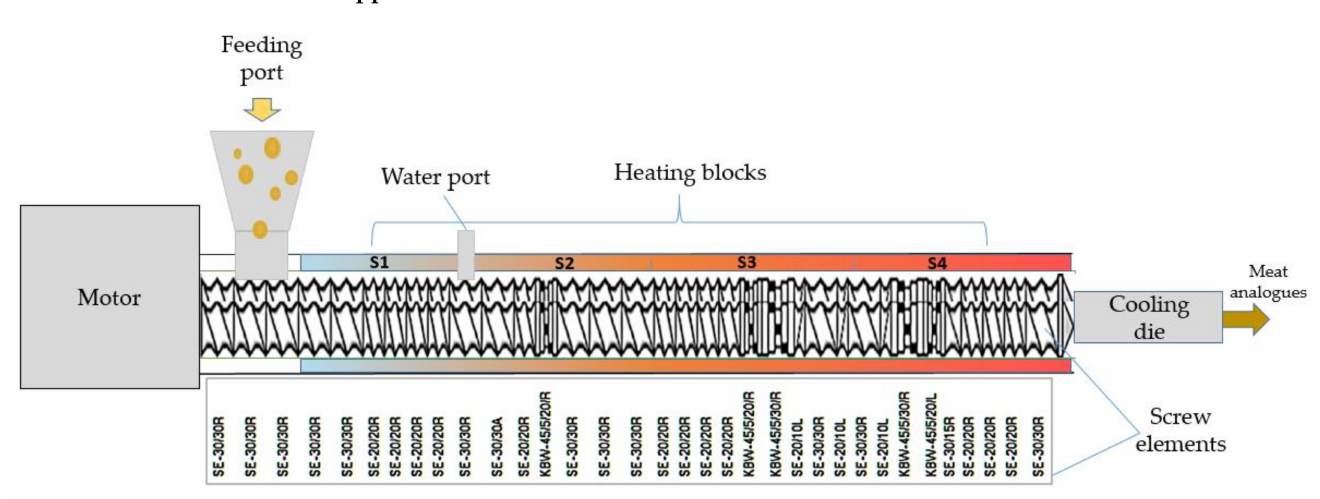
Figure A1. Schematic illustration of high-moisture extrusion (HME) with twin-screw extruder (KETSE 20/40D, Brabender GmbH and Co., Duisburg, Germany) and the screw configuration. S1, S2, S3 and S4 = heating sections in barrel, SE = screw element, KBW = kneading